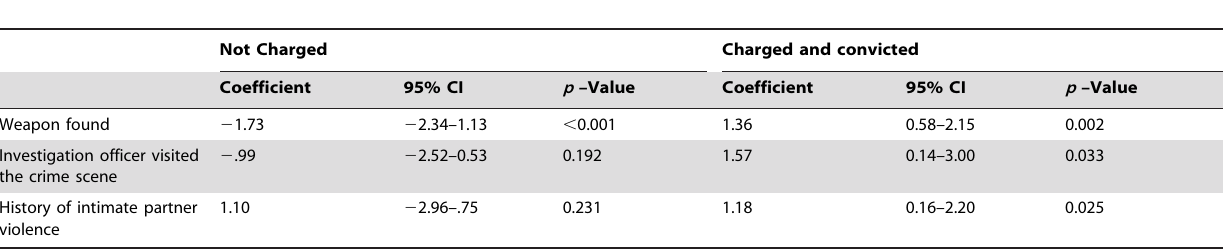
Table 2. Multinomial logistic regression showing the associations between the state of charged and not convicted with not charged and charged and convicted (reference group is charged and not